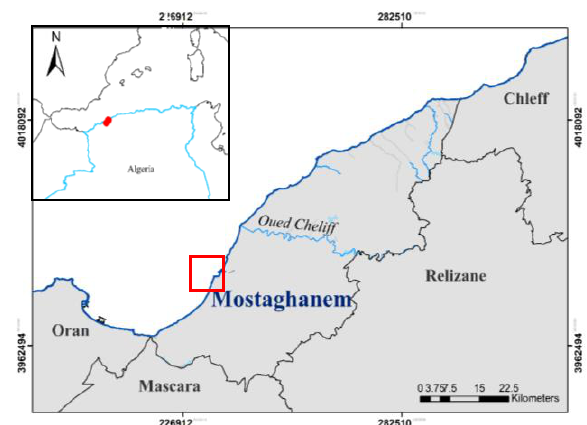
Figure 1 . Geographic situation of the study